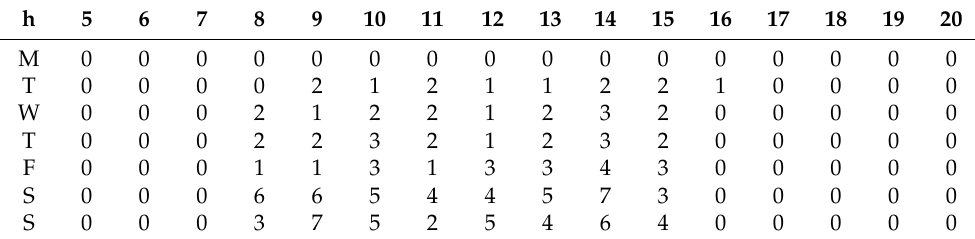
Table 7. Average weekly departure scheme at